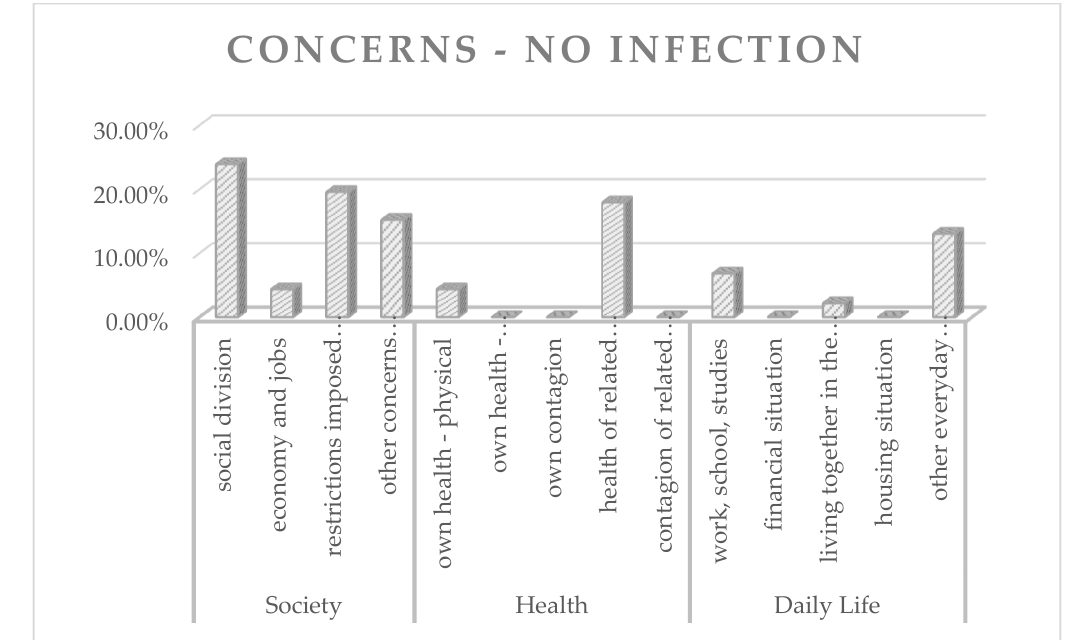
Figure 3. Percentages of pandemic-related concerns within the group “Long-Covid” .